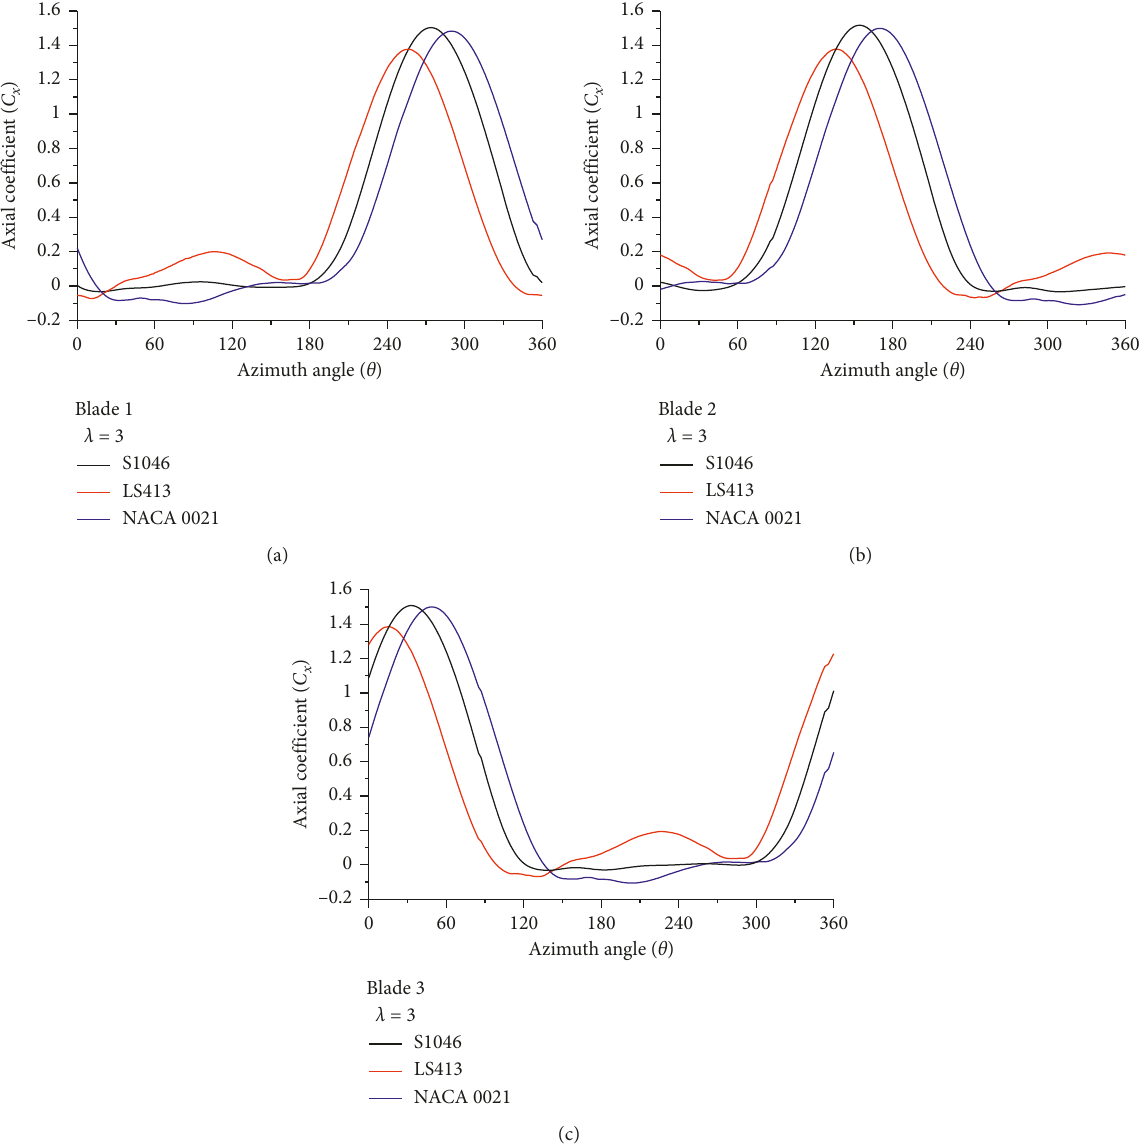
Figure 15: Instantaneous dynamic axial force coefficients on the Darrieus rotor located at every